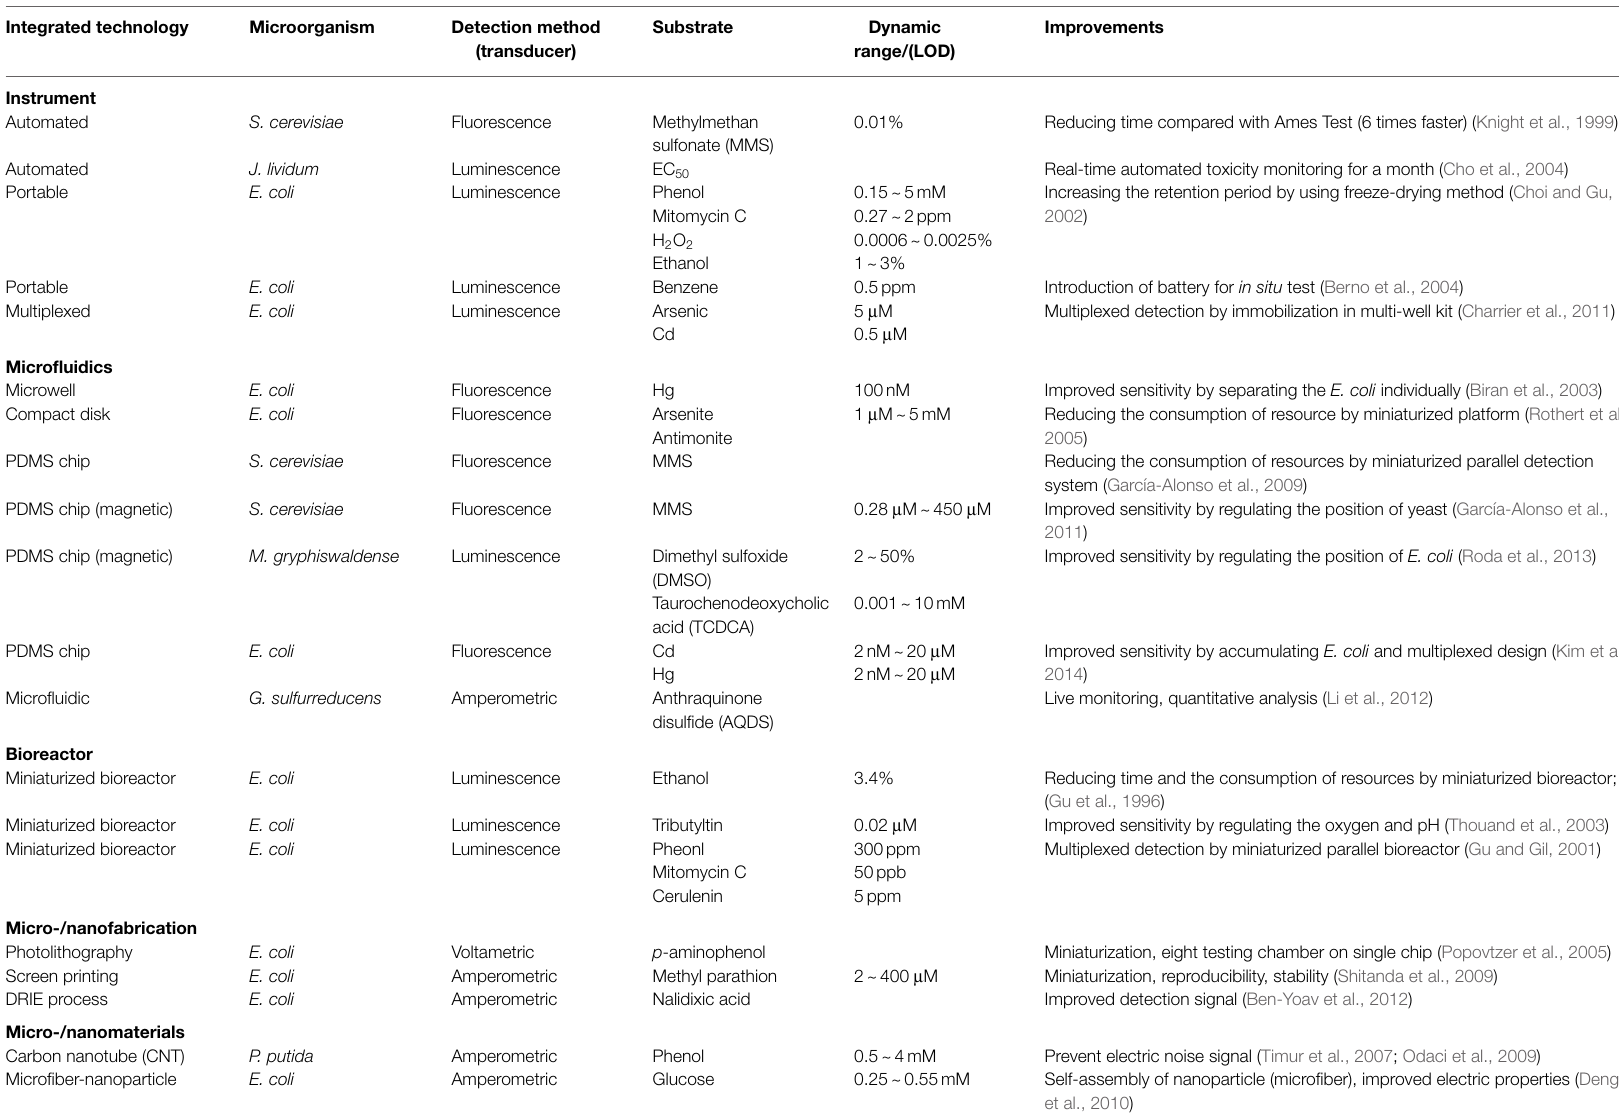
TABLE 1 | Comparison of microbial biosensors integrated with micro/nanotechnologies